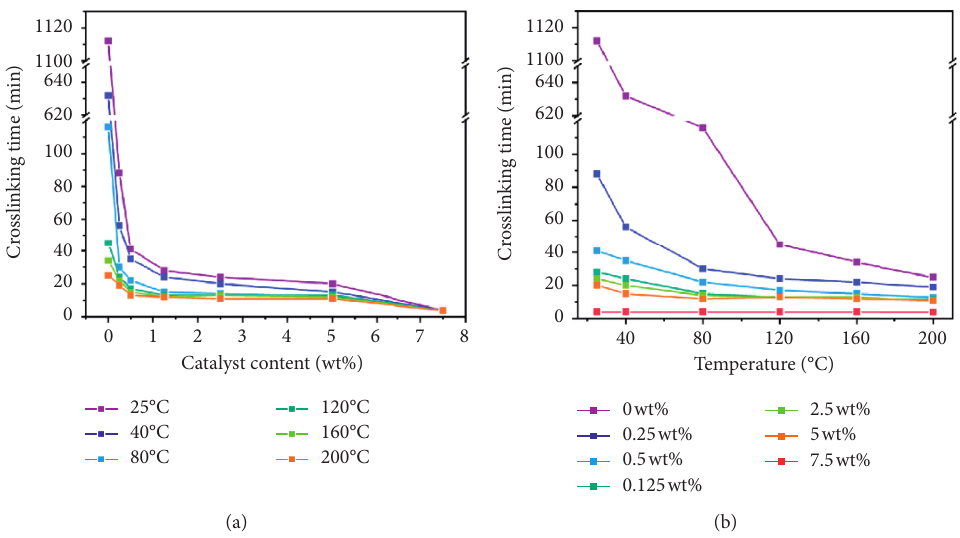
Figure 7: Plot of the crosslinking as a function of (a) the catalyst content and (b) temperature.